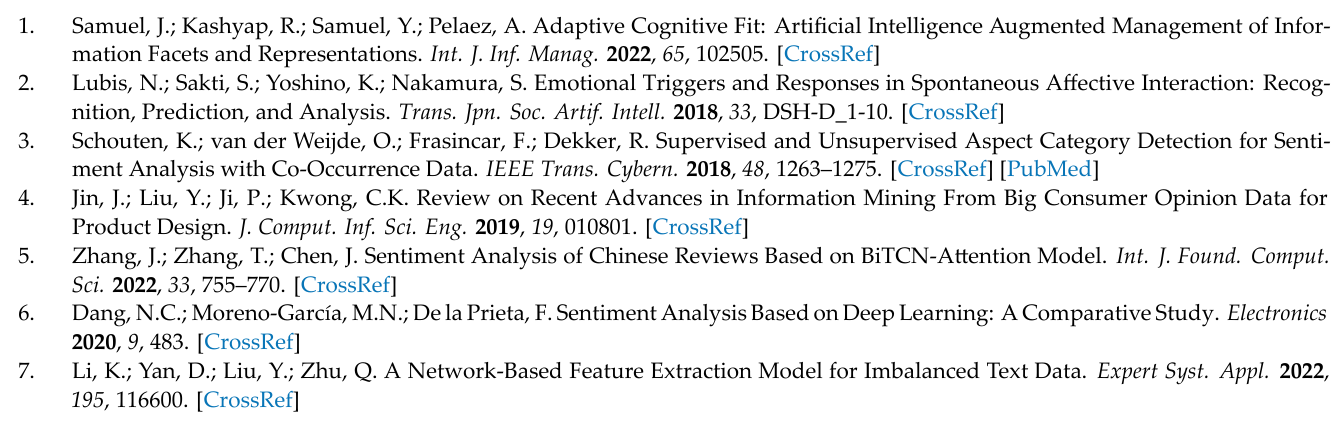
Figure A2. Bi-LSTM network structure diagram.